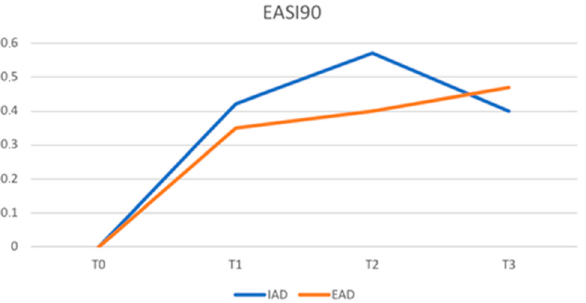
Figure 2. Proportion of patients achieving a 90% improvement in the EASI (EASI90) (IAD = intrinsic atopic dermatitis; EAD = extrinsic atopic dermatitis).